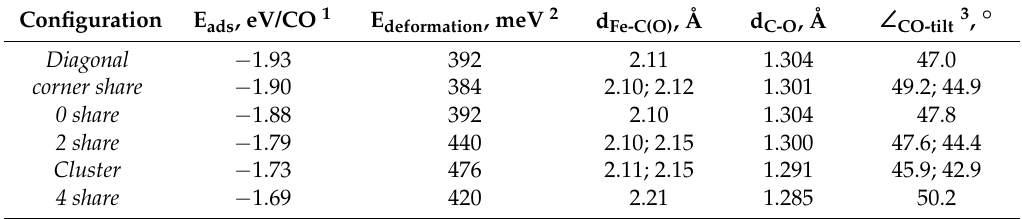
Table 1. DFT-optimized geometry of CO adsorbed on p(4x4)-Fe(100) ( Θ CO = 0.25 ML) in different geometric configurations (see Figure 1).